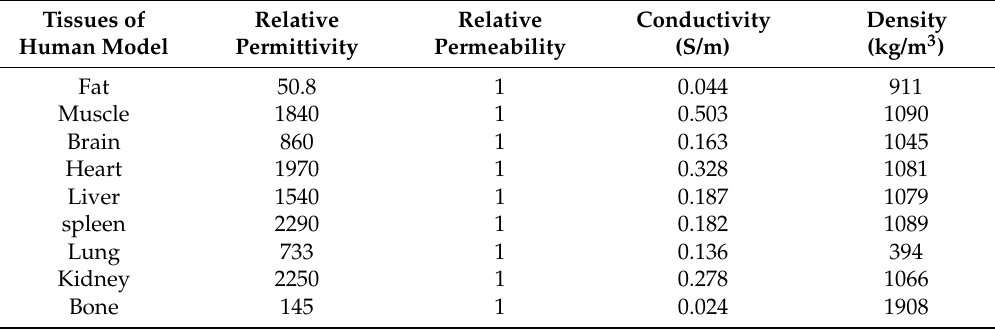
Table 2. Parameters of typical tissues at the operating frequency (1 MHz).